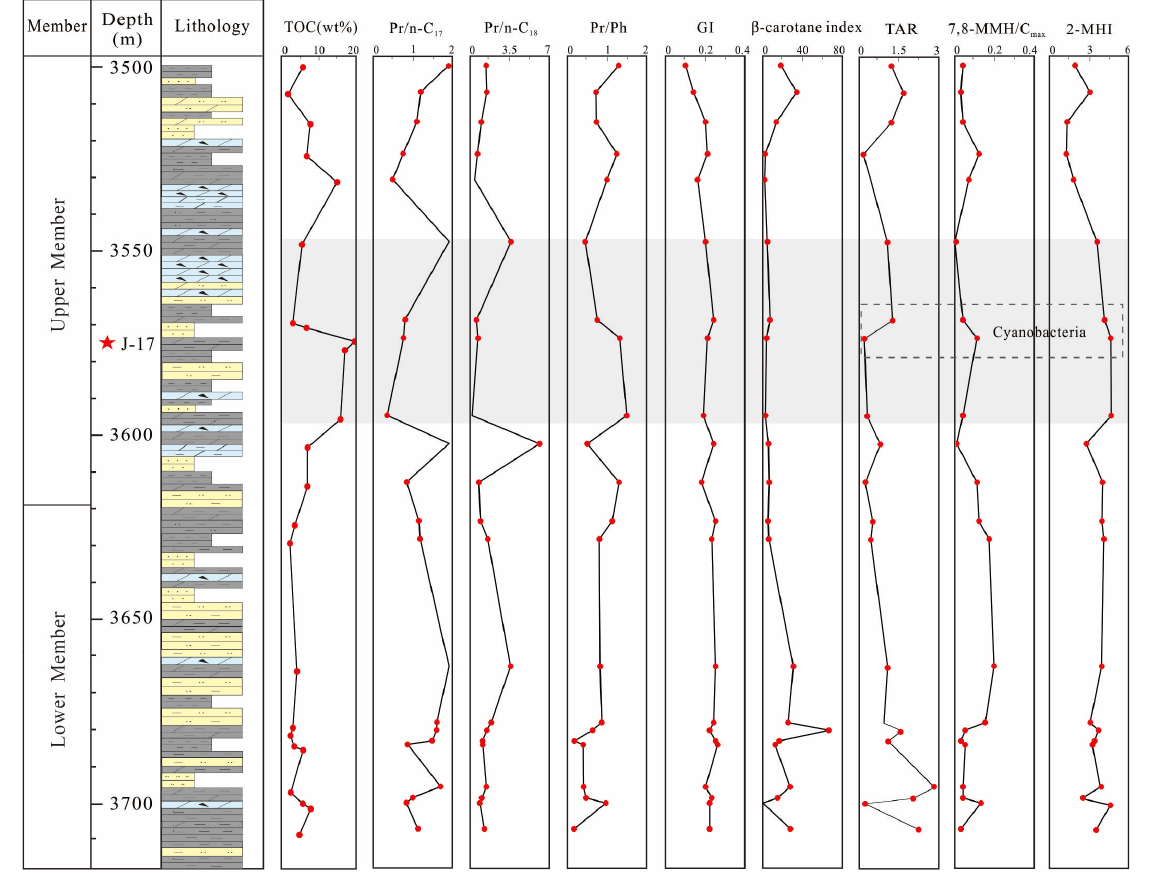
Figure 8. Biomarkers of the Lucaogou Formation (the red star marks the sample location of the microfossil J-17, 3574.2 m).